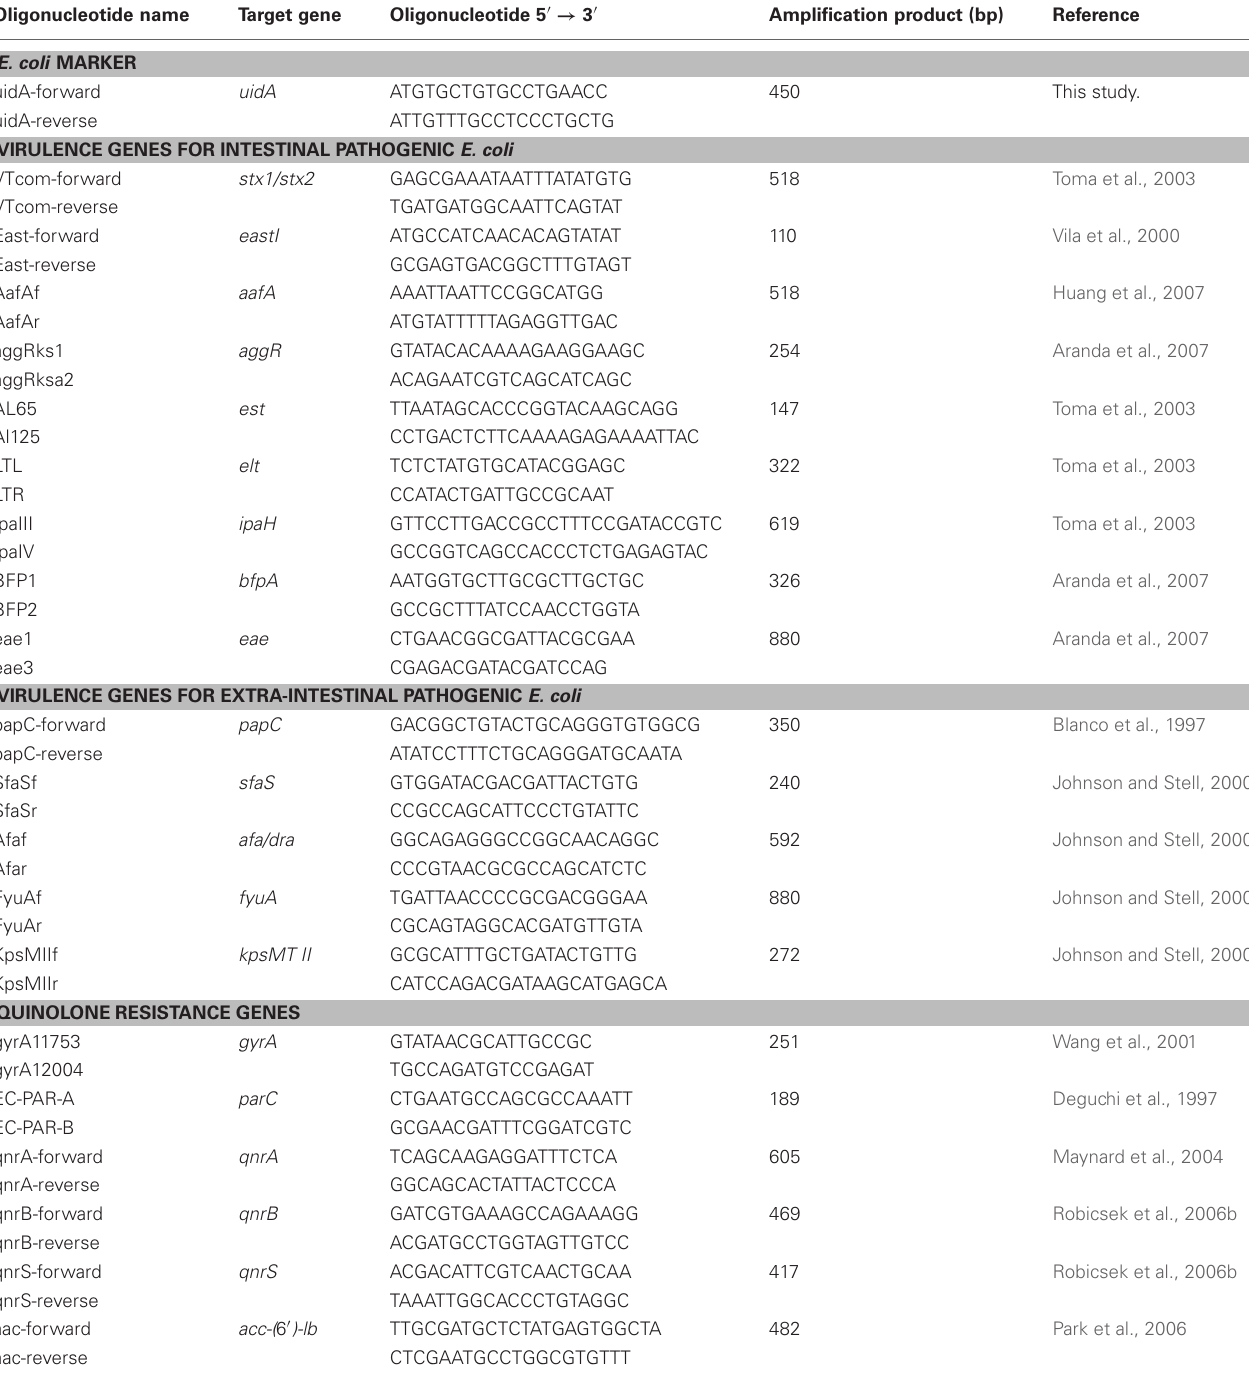
Table 2 | Oligonucleotides used in this